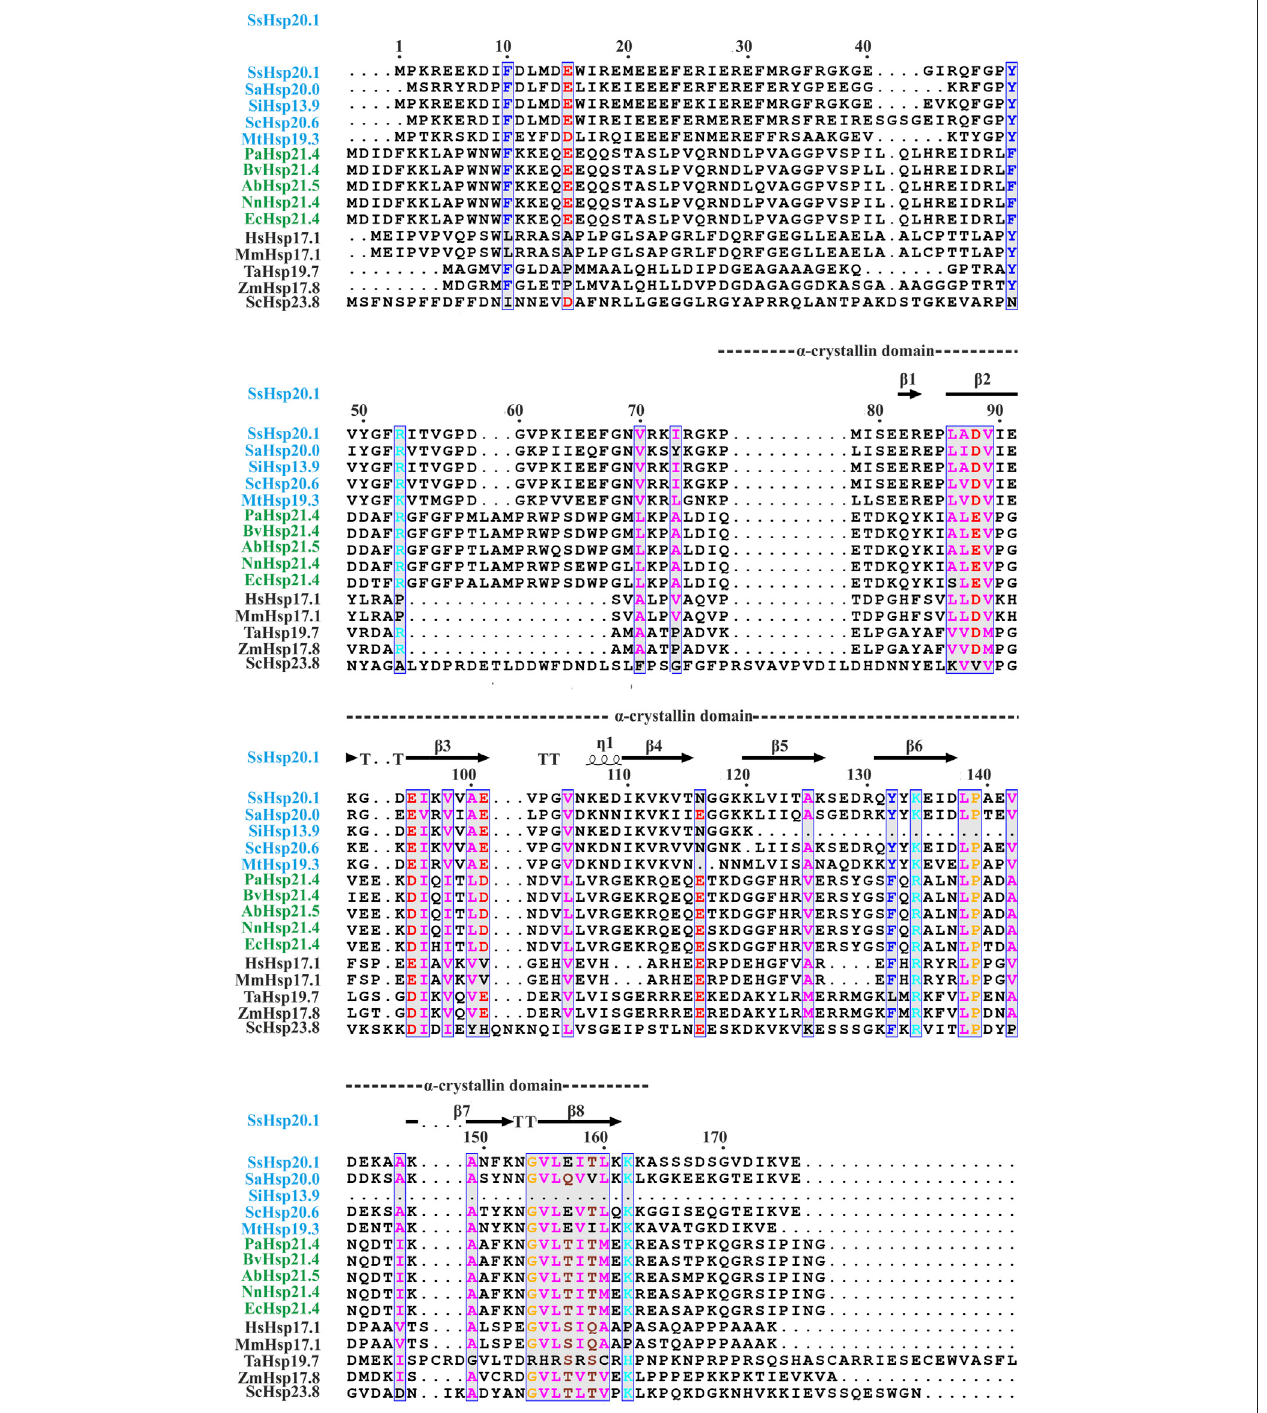
FIGURE1| AminoacidsequencealignmentofHsp20proteinfamilyfromarchaea(blue),bacteria(green),andeukaryotes(black).Secondarystructuraldomainsat the top are based on SsHsp20.1 ACD (4-RZK) crystal structure. Amino acids in blue boxes represent similarity across groups. Abbreviations for sHsps: SsHsp20.1 ( Sulfolobussolfataricus Hsp20.1),SaHsp20.0( Sulfolobusacidocaldarius Hsp20.0),SiHsp13.9( Sulfolobusislandicus Hsp13.9),ScHsp20.6( Saccharolobuscaldissimus Hsp20.6), MtHsp19.3 ( Metallosphaera tengchongensis Hsp19.3), PaHsp21.4 ( Pseudomonas aeruginosa Hsp21.4), BvHsp21.4 ( Burkholderia vietnamiensis Hsp21.4), AbHsp21.5 ( Acinetobacter baumannii Hsp21.5), NnHsp21.4 ( Nitrosomonas nitrosa Hsp21.4), EcHsp21.4 ( Escherichia coli Hsp21.4), HsHsp17.1 ( Homo sapiens Hsp17.1), MmHsp17.1 ( Macaca mulatta Hsp17.1), TaHsp19.7 ( Triticum aestivum Hsp19.7), ZmHsp17.8 ( Zea mays Hsp17.8), ScHsp23.8 ( Saccharomyces cerevisiae Hsp23.8). Multiple sequence alignment was carried out using ESPript 3.0 and Clustal W.